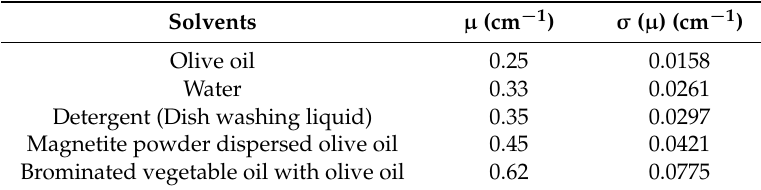
Table 1. Solvents with their experimental linear X-ray attenuation coefficient ( µ ) and the achieved standard deviation σ ( µ ) indicating the close proximity in attenuation coefficient values of test fluids and attenuation coefficient enhancement of olive oil by addition of contrast agents.